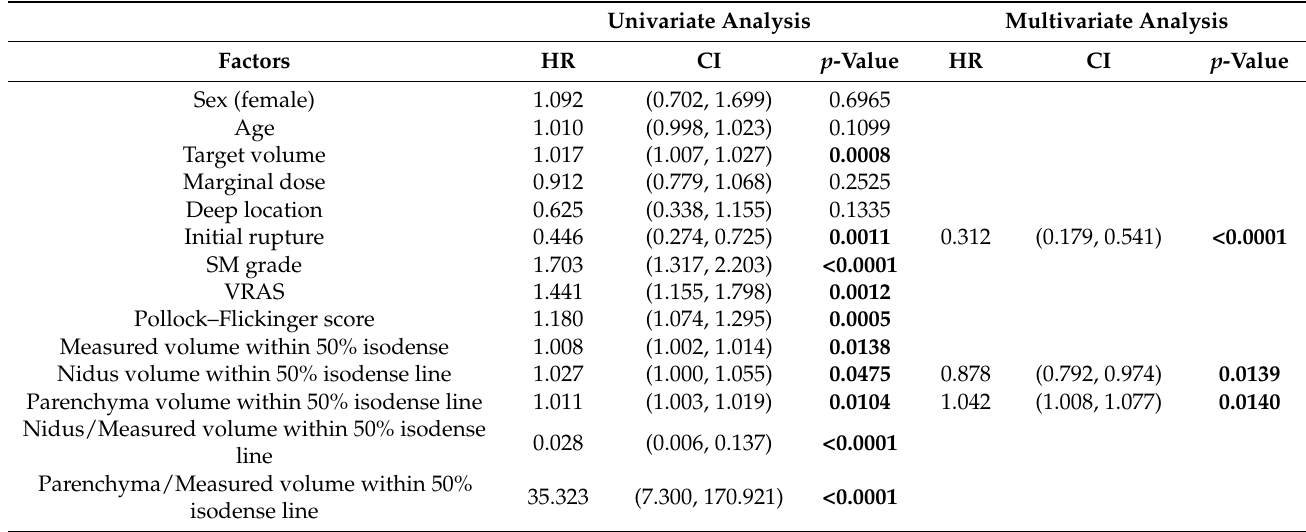
Table 3. Univariate and multivariate Cox proportional hazards regression analyses for predictors of radiation-induced change (RIC) after GKRS.